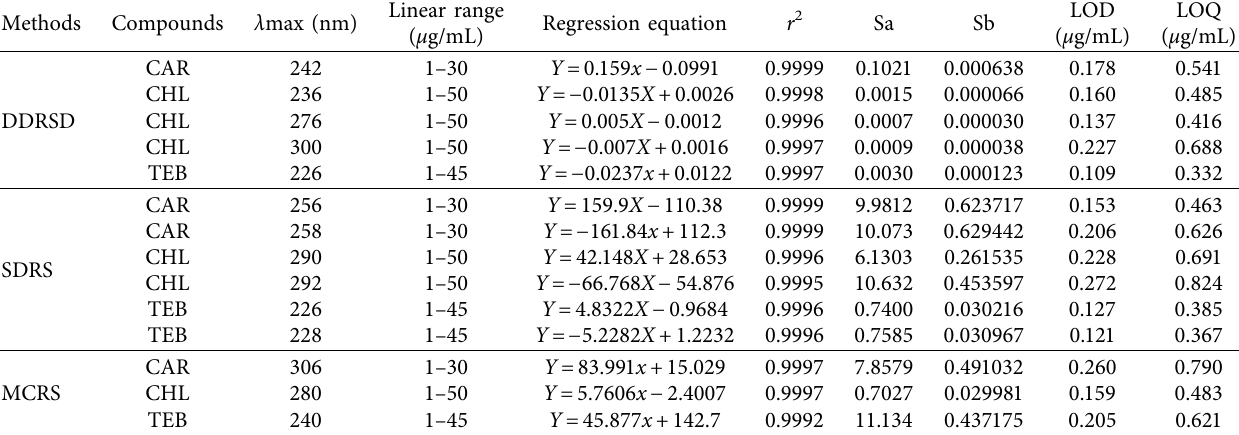
Table 1: Calibration data for the determination of carboxin, chlorpyrifos, and tebuconazole by the proposed methods. Methods